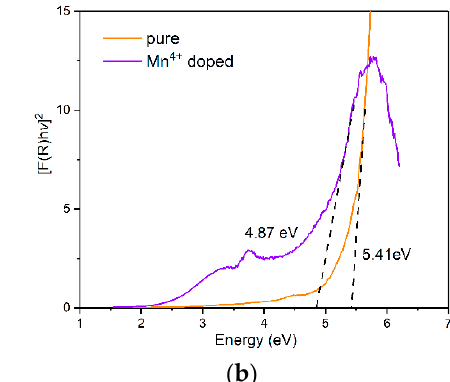
Figure 4. ( a ) Diffuse reflectance spectrum and ( b ) energy band gap of pure and Mn 4+ doped [N(CH 3 ) 4 ] 2 ZrF 6 samples at room temperature.